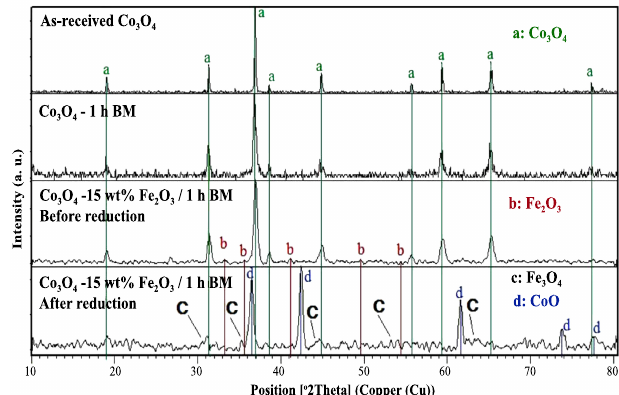
Fig. 6. XRD patterns of as-received Co 3 O 4 , 1 h ball milled Co 3 O 4 , and Co 3 O 4 -15 wt% Fe 2 O 3 /1 h BM before and after